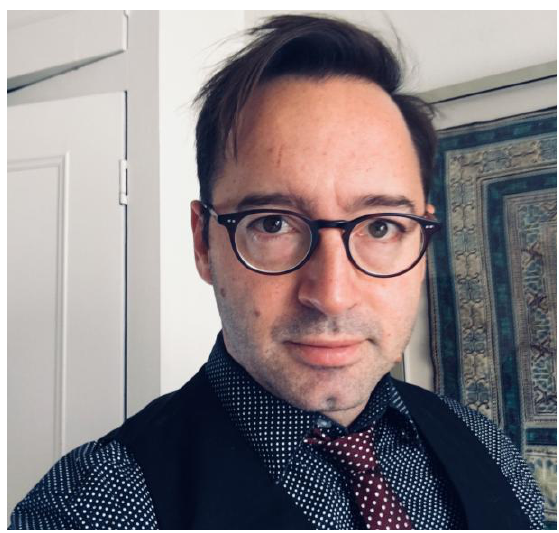
Figure 1. Director Adrian Goycoolea. Picture courtesy of Adrian Goycoolea.